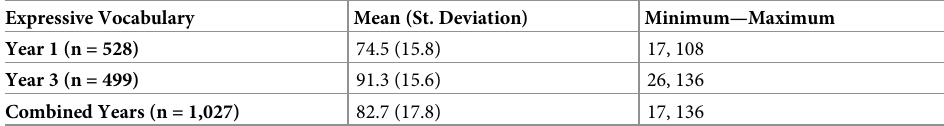
Table 2. Descriptive statistics for raw scores of expressive vocabulary by year.